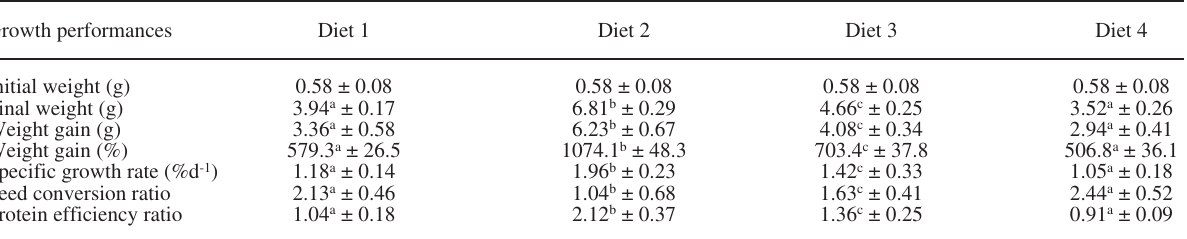
t able 2. – Growth performance of gilthead sea bream ( S. aurata L.) juveniles fed different salt-added diets for 10 weeks (values given are the mean of three replicates ± standard